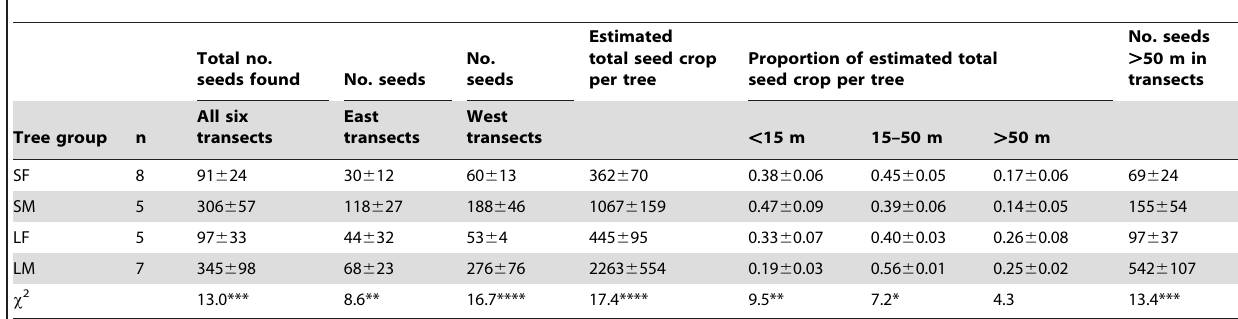
Table 2. Seed dispersal patterns of mahogany ( Swietenia macrophylla ) trees (n=25) at the Marajoara forest in Para´, Brazil.